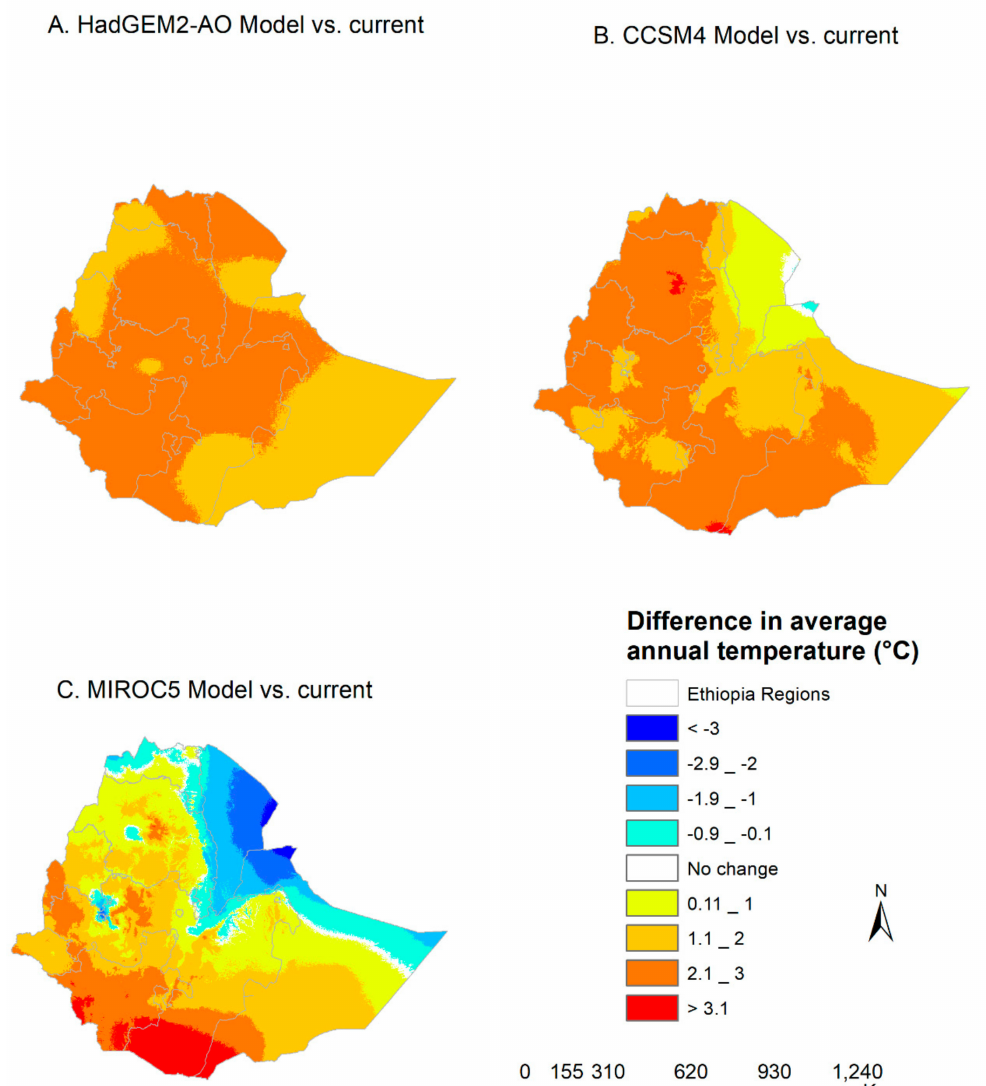
Figure 6. Di ff erences in annual temperatures due to projected climate change between current climate (1970–2000) and three models (( A ) HadGEM2-AO, ( B ) CCSM4, and ( C ) MIROC5) representing the 4.5 representative concentration pathway (RCP) for the period of 2041–2060 in